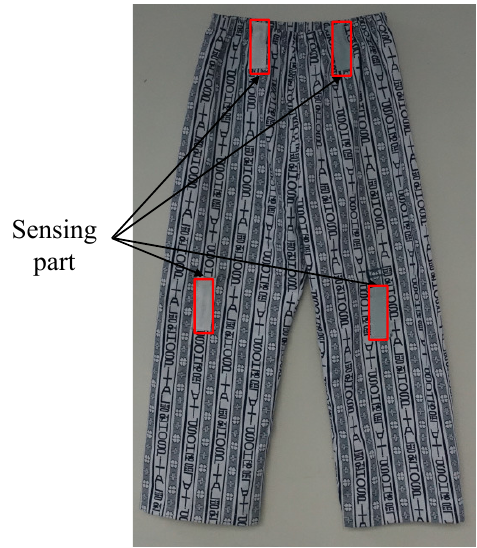
Figure 1. Patient clothing for four flexible